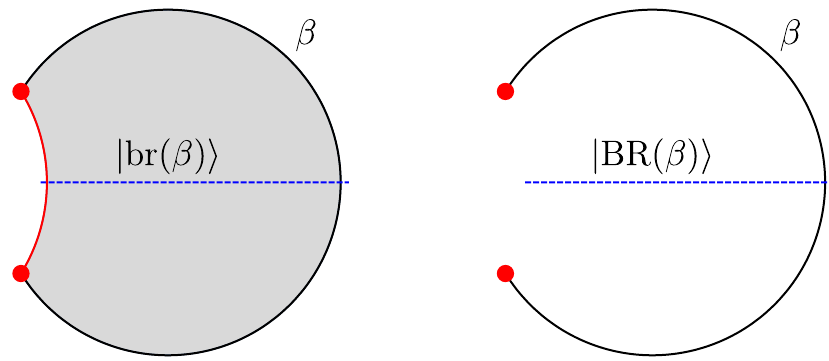
Figure 2 . (Left) The disk contribution to the bulk Euclidean path integral computing the one-brane (red curve) partition function. The boundary has renormalized length β . Cutting the path integral along the dashed blue line gives a state in H br , the Hilbert space of dilaton gravity on an interval with one asymptotic boundary and one brane boundary. (Right) The boundary Euclidean path integral computing the one-brane partition function. Cutting the path integral along the dashed blue line gives the projected thermofield double state h S µ | TFD ( β ) i , which we call | BR ( β ) i in (2.11), in the microscopic Hilbert space H B . The red dots are brane boundary